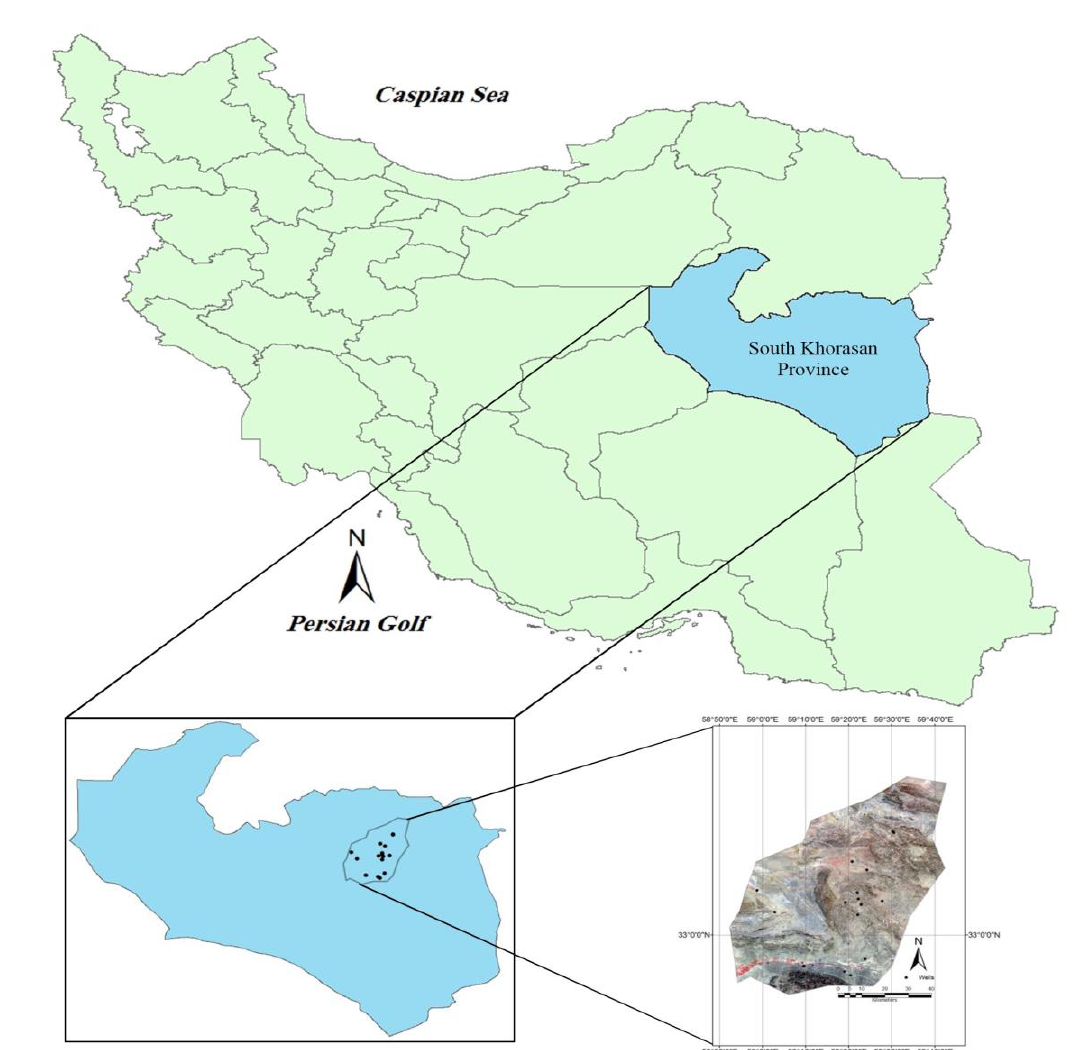
Figure 1. The location of study area in Birjand, South Khorasan